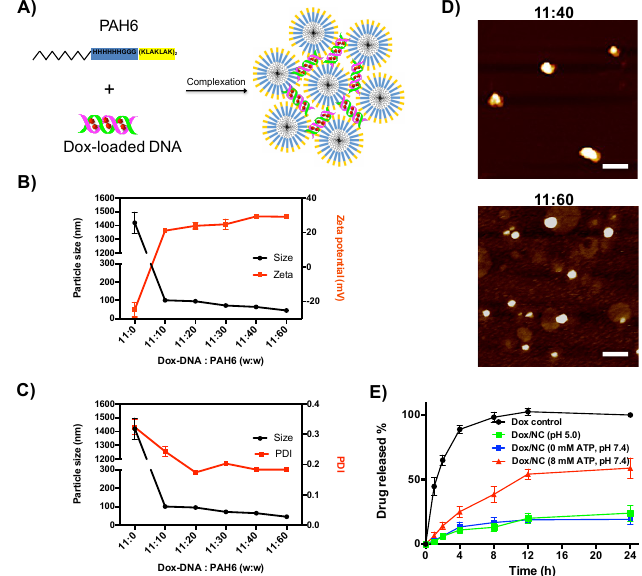
Figure 2. ( A ) Schematic illustration of the mechanism for the formation of the Dox-DNA/PAH6 NC. ( B ) The averaged particle size and zeta potential of the Dox-DNA/PAH6 NC at different mass ratios of Dox-DNA and PAH6. Error bars represent SD ( n = 3). ( C ) The averaged particle size and polydispersity index (PDI) of the Dox-DNA/PAH6 NC at different mass ratios of PAH6 and Dox-DNA. Error bars represent SD ( n = 3). ( D ) AFM images of the Dox-DNA/PAH6 NC at the mass ratios of Dox-DNA to PAH6 of 11:40 and 11:60, respectively. The scale bar indicates 100 nm. ( E ) The Dox release profile of the Dox-DNA/PAH6 NC in the presence of 8 mM ATP. Error bars represent SD ( n = 5). Atomic force microscopy (AFM) was then used to investigate the nanostructures of Dox-DNA/PAH6. The AFM images showed that both Dox-DNA/PAH6 (11:40) and Dox-DNA/PAH6 (11:60) formed spherical nanoparticles and their size distributions were consistent with the DLS results (Figure